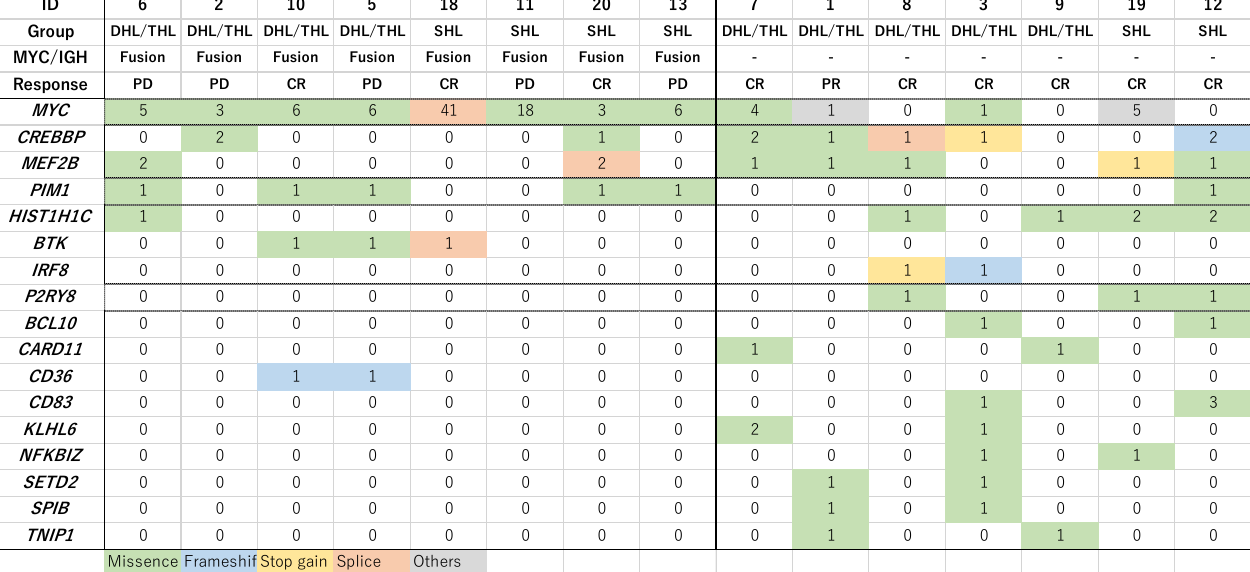
Figure A3. Correlation between MYC / IGH , response to treatment, and mutational profile. Missence, green; frameshift, blue; stop gain, yellow; splice, red; and others, grey. PD—progressive disease; CR—complete response; PR—partial response.